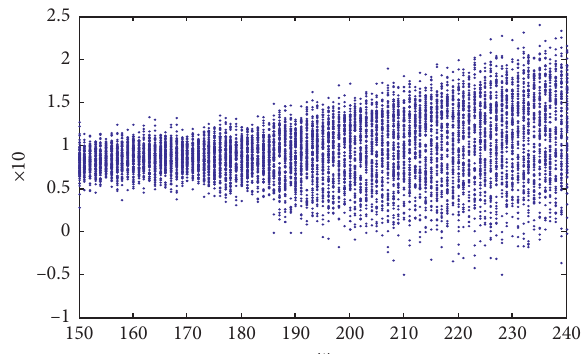
Figure 48: Vibrational bifurcation diagram with δ ∗